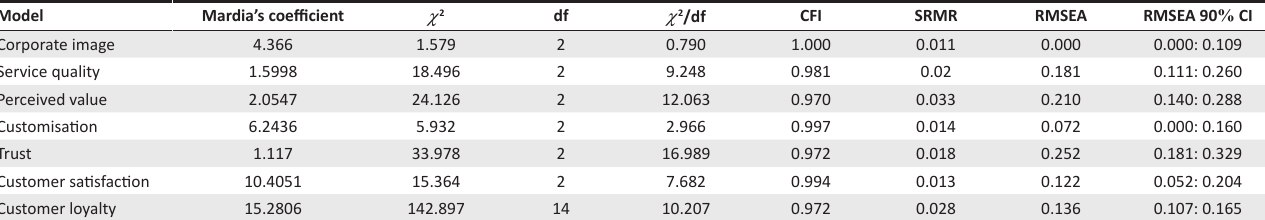
TABLE 2: Confirmatory factor analysis results.